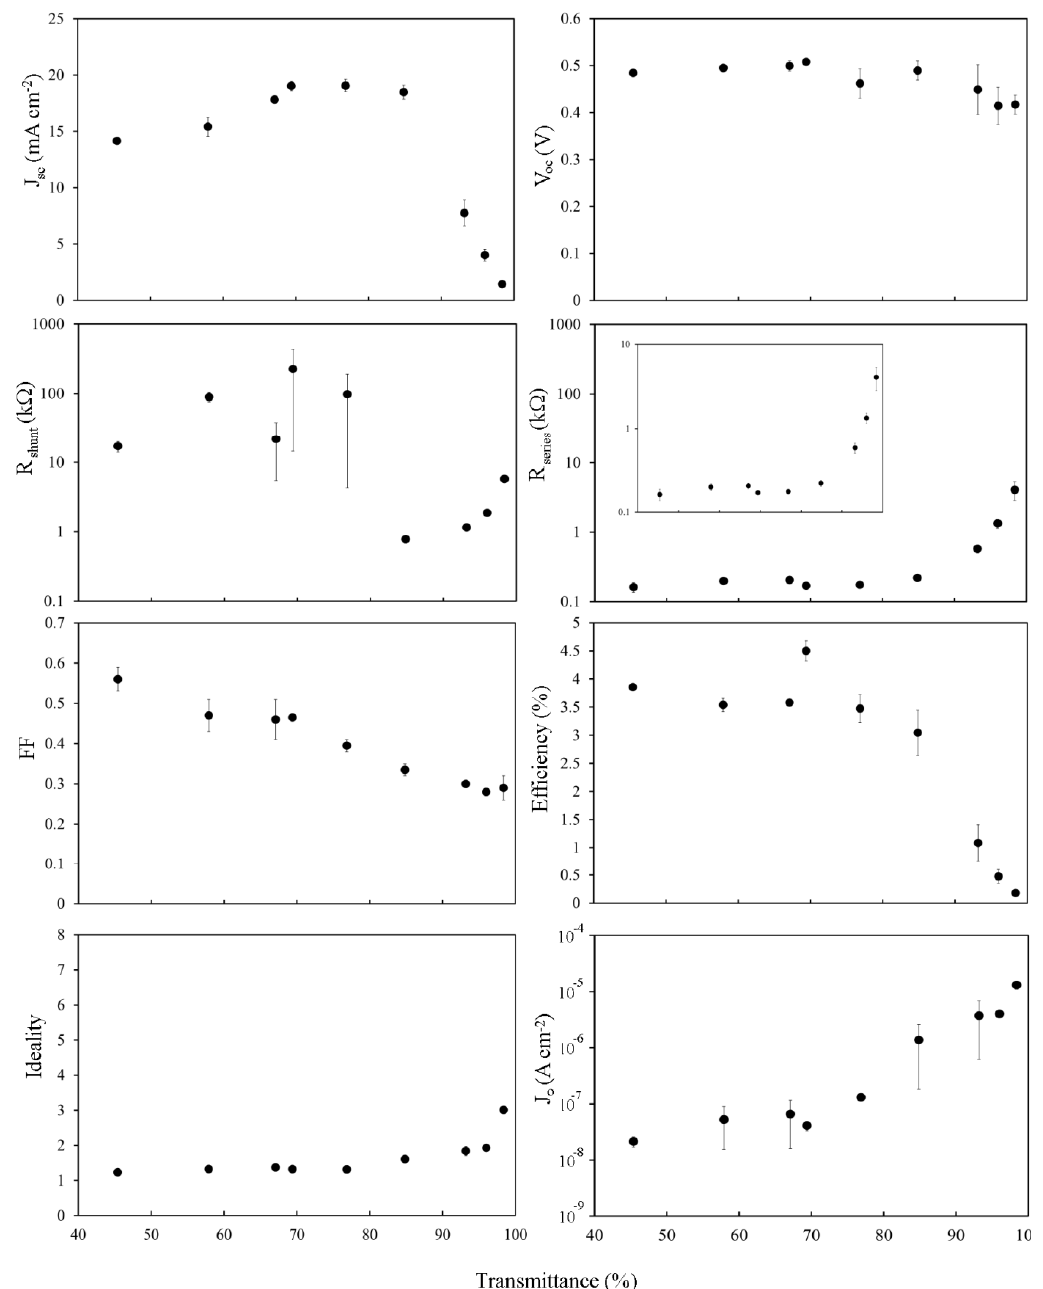
Figure 7. Solar cell parameters extracted from HF treated (second treatment) SWCNT-Si devices with varying SWCNT film thickness, 1 h after